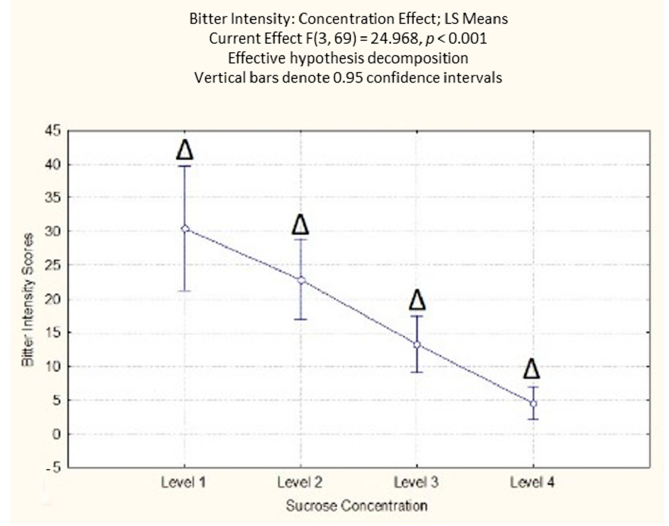
Figure 4. Concentration effect on perceived bitterness responses with different sucrose concentration levels. The order of the levels corresponds with the different sucrose amounts (38; 83; 119; 233 g/kg). Δ indicates a significant difference from all other sucrose levels <0.05.